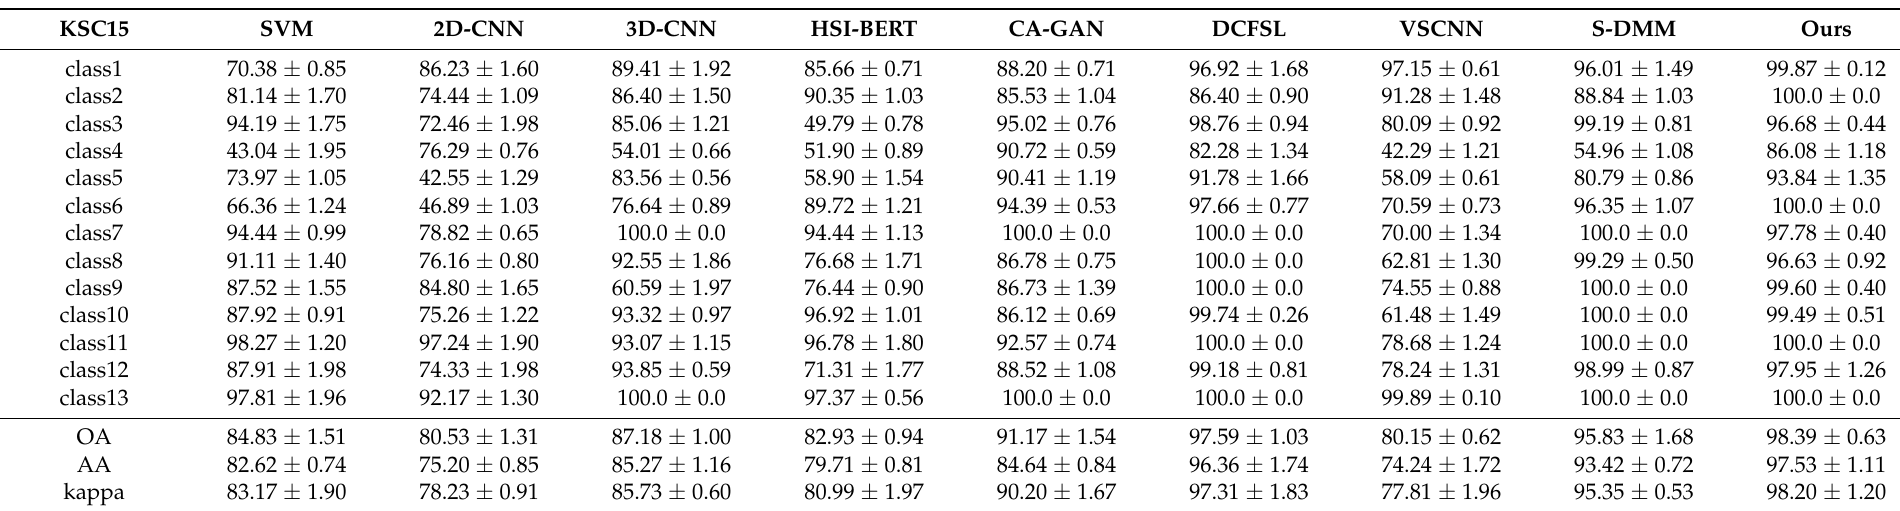
Table 13. The classification results of our proposed and other leading methods on the Kennedy Space Center